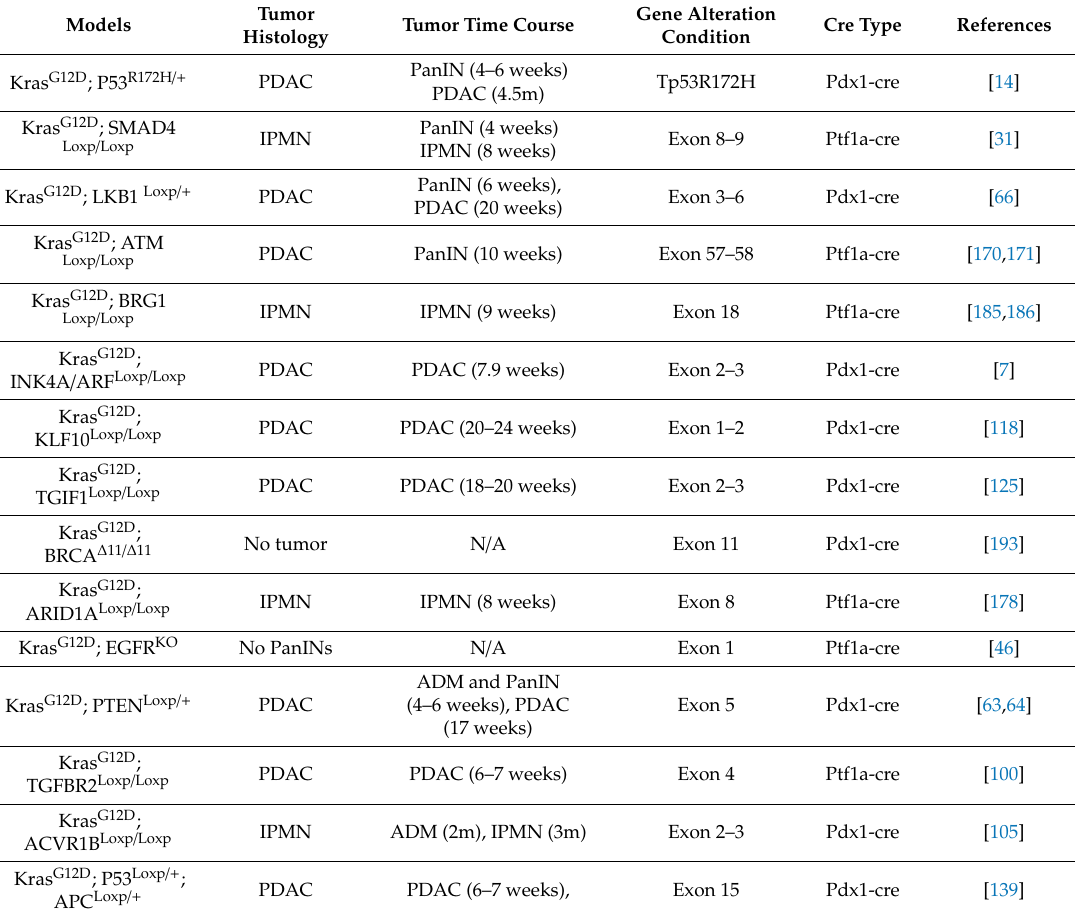
Table 1. List of mouse models studying driver genes in pancreatic